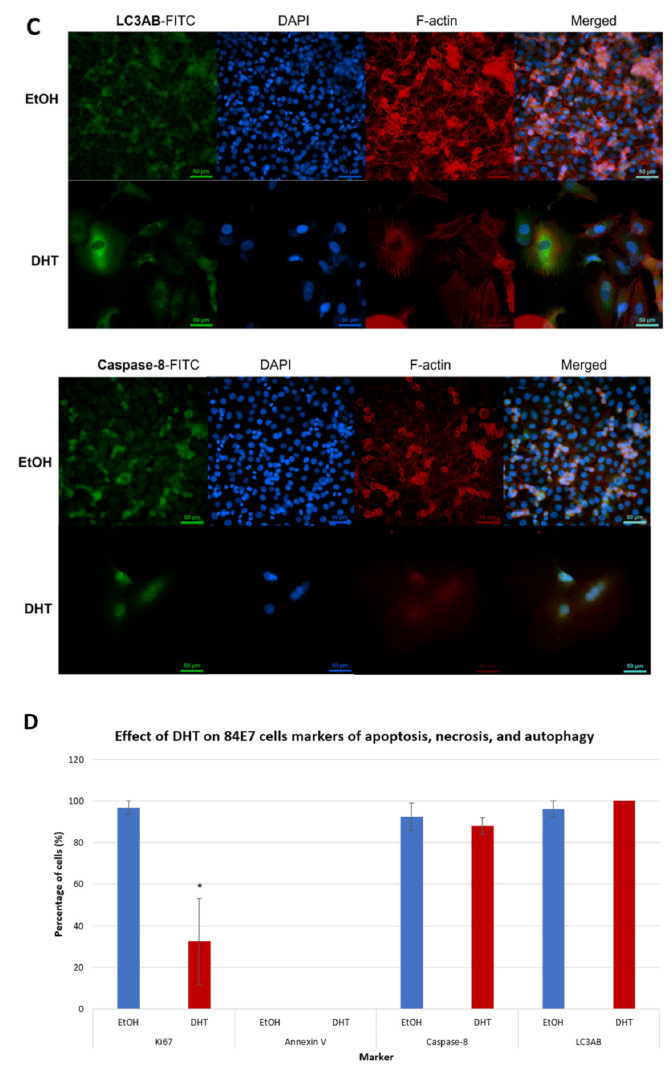
Figure 5. Effect of 84E7 AR activation on markers of proliferation, apoptosis, necrosis, and autophagy. ( A ) AR activation reduced proliferative potential, demonstrated by decreased expression of Ki67, a marker of proliferation. ( B ) AR activation did not cause apoptosis, demonstrated by lack of positive staining using Annexin-V or PI. Cells treated with cycloheximide as a positive control showed green staining fluorescence for Annexin-V (apoptosis), and red staining for PI (necrosis) (top panel). Nuclear DNA was stained blue by Hoechst 33,342 stain. ( C ) Continuous AR activation did not initiate apoptosis or autophagy in 84E7 cells, indicated by a lack of significant change in expression of caspase-8 and LC3A/B. ( D ) Quantification of immunofluorescence data revealed a significant decrease (36%; * p < 0.05) in proliferation marker Ki67 and no significant change in apoptosis, necrosis, or autophagy